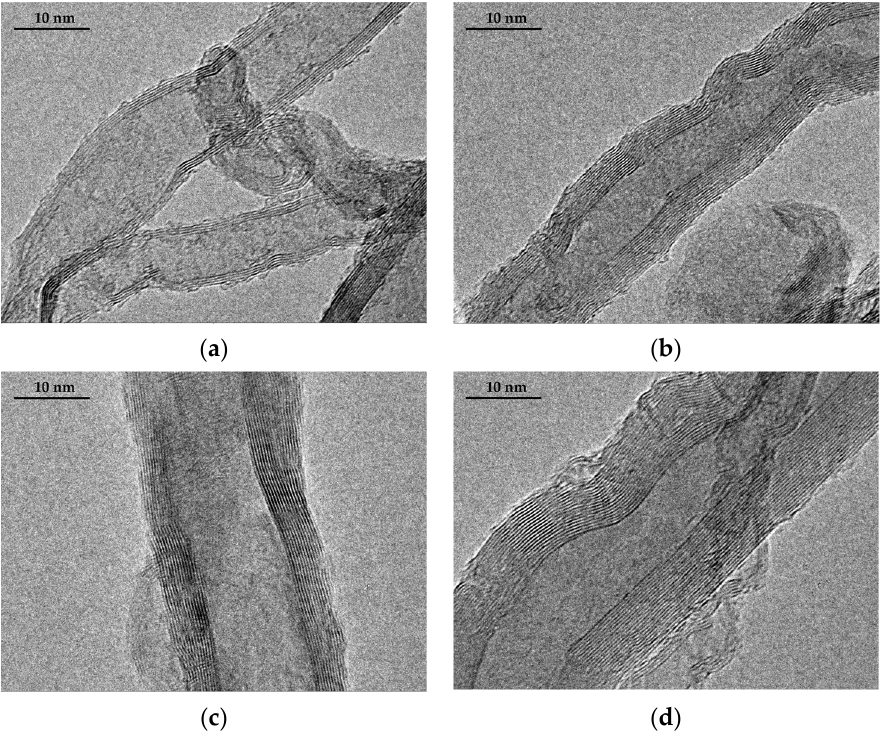
Figure 4. TEM images of CNTs synthesized at 15 ( a ); 30 ( b ); 45 ( c ); 60 min ( d ).